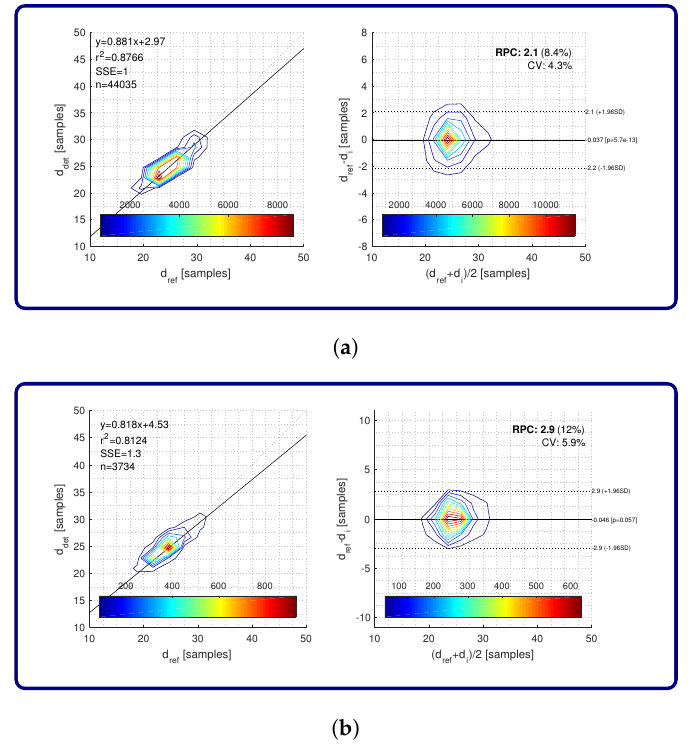
Figure 7. Regression analysis and Bland–Altman plots of stride time matching between detected strides and ground truth: ( a ) all strides; ( b ) transitions. Color map represents the number of